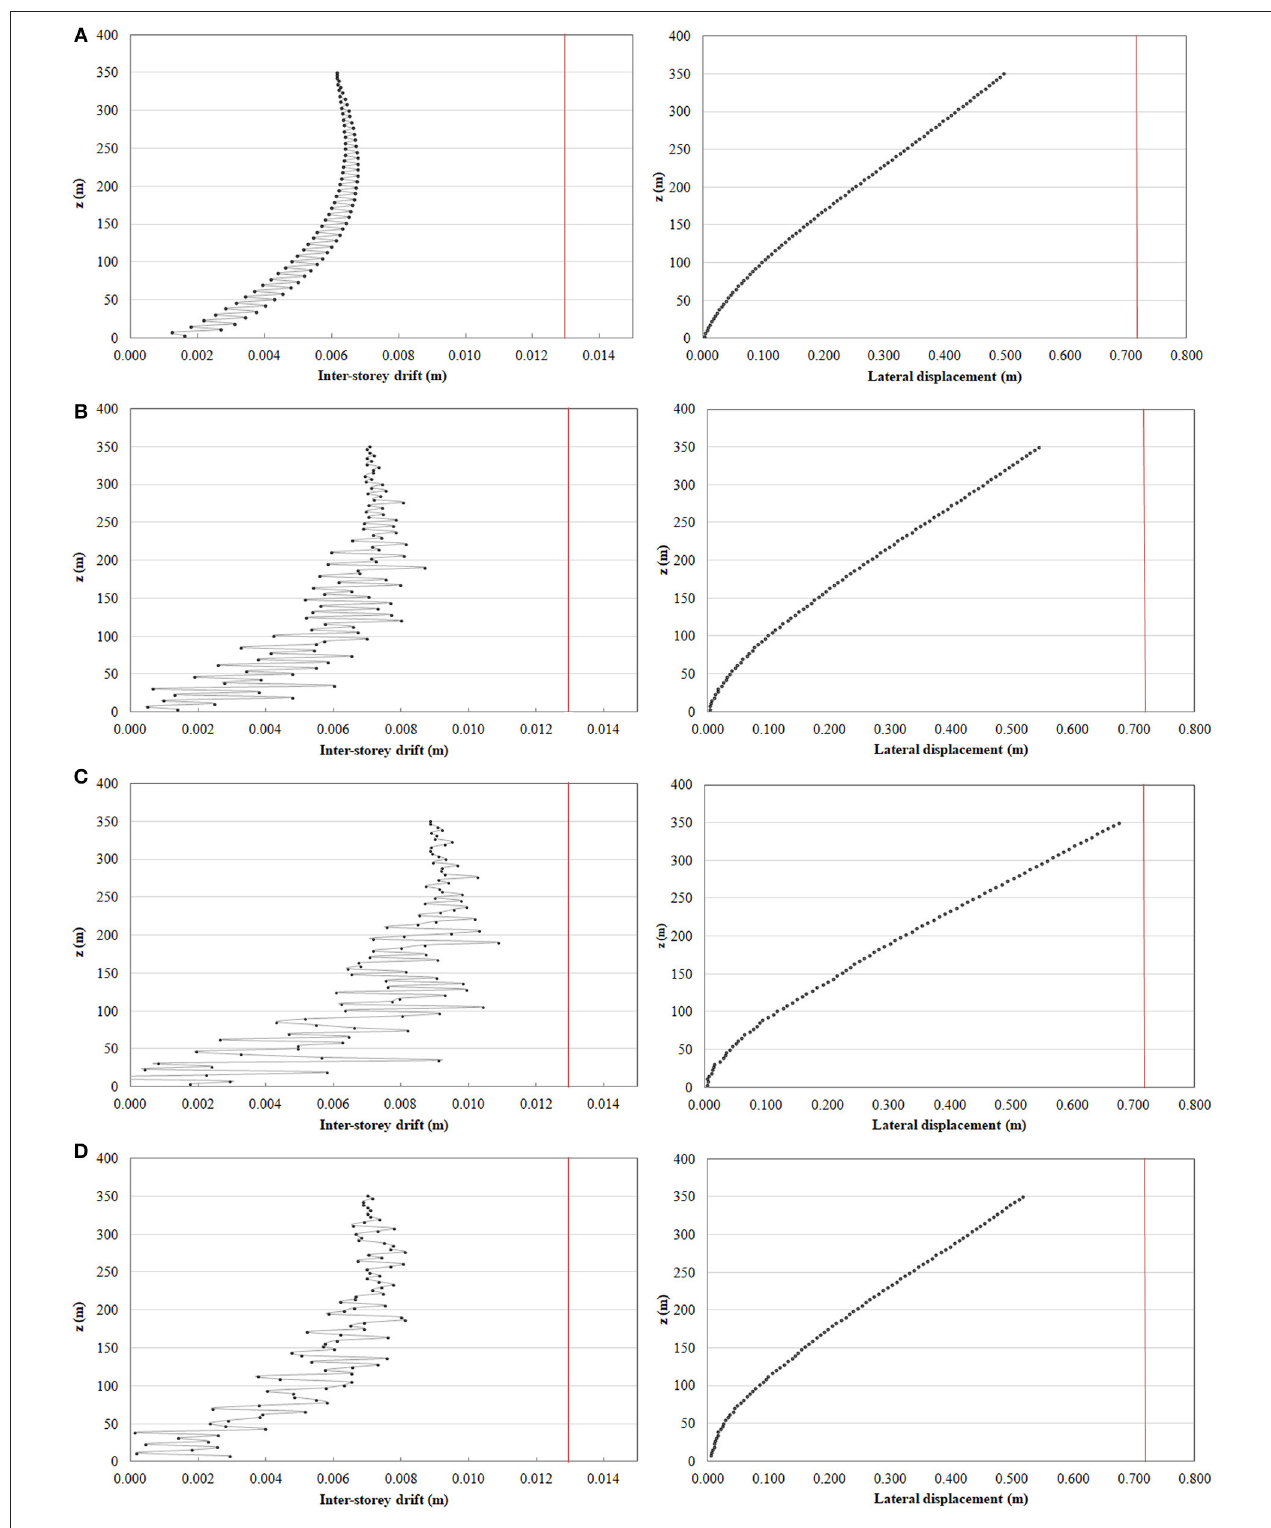
FIGURE 9 | Inter-story drifts (on the left) and lateral displacements (on the right) under wind forces: (A) regular hexagrid model with α (C) model with α 0.7 and (D) model with α =